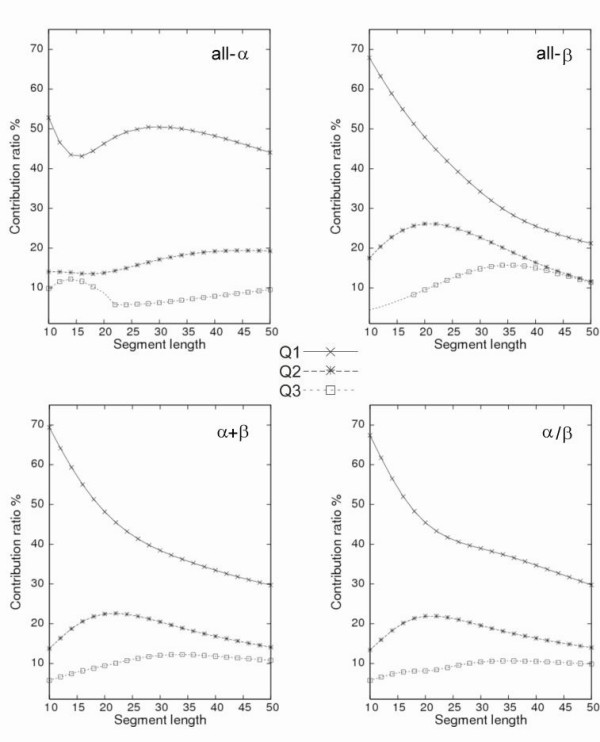
Contribution ratios for the PC axes for each structural class. Contribution ratios (Q1, crosses; Q2, asterisks; and Q3, squares) of PCx1-PCx3 vs. segment lengths of 10–50 residues for each structural class, where x = α, β, α+β, or α/β. The correlation coefficient between PCxi and PCalli (i = 1, 2, 3) is 0.7 or less if no mark is present at a segment length. For the all-β class, no axis exhibited a correlation coefficient greater than 0.7 up to PCall3 for segment lengths of 10–16 residues.